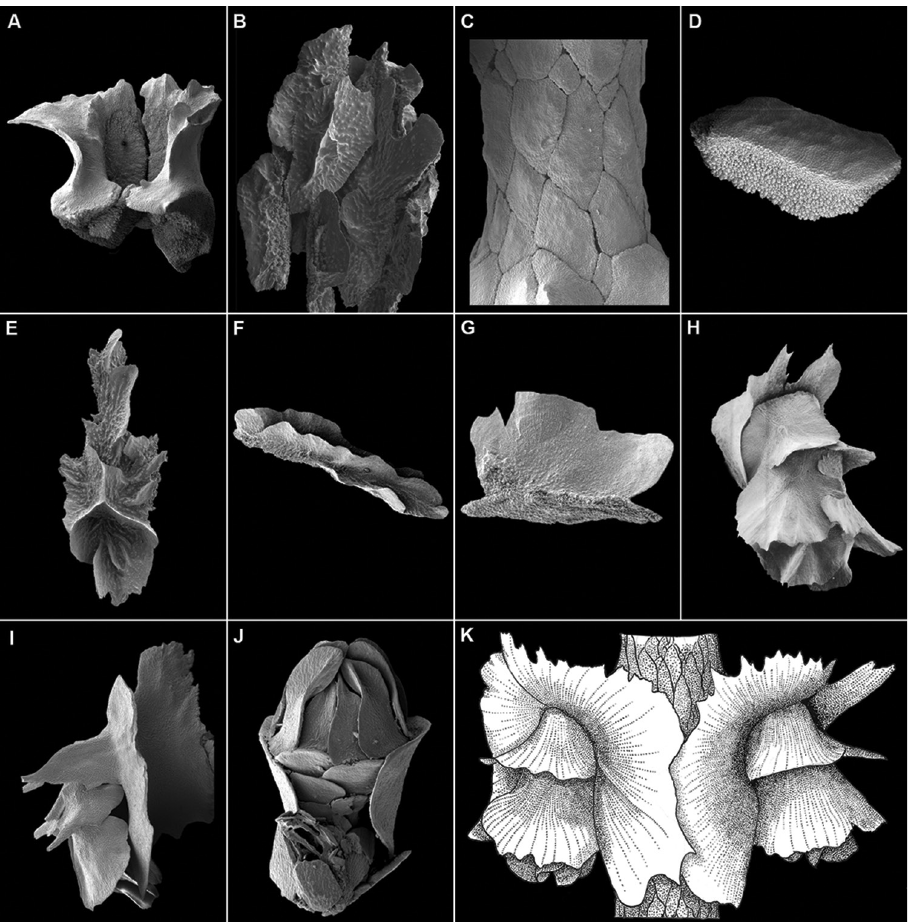
Figure 2. A massive basal scales of N. clavata B thin, imbricate coenenchymal scales of N. fordi C thick, mosaic arranged coenenchymal scales of N. mosaica D individual thick coenenchymal scale of N. mosaica with a finely granular outer surface E complexly ridged coenenchymal scale of N. muzikae F single medial coenenchymal ridge of N. pauciflora G sail scale of N. spectabilis H serrate distal margin of body wall scales of N. bowersi I spinose body wall scales of N. horrida J adaxial body wall scales of N. dampieri K polyp pair of N. leilae showing extensive cowl and serrate distal edges of body wall scales (from Bayer,